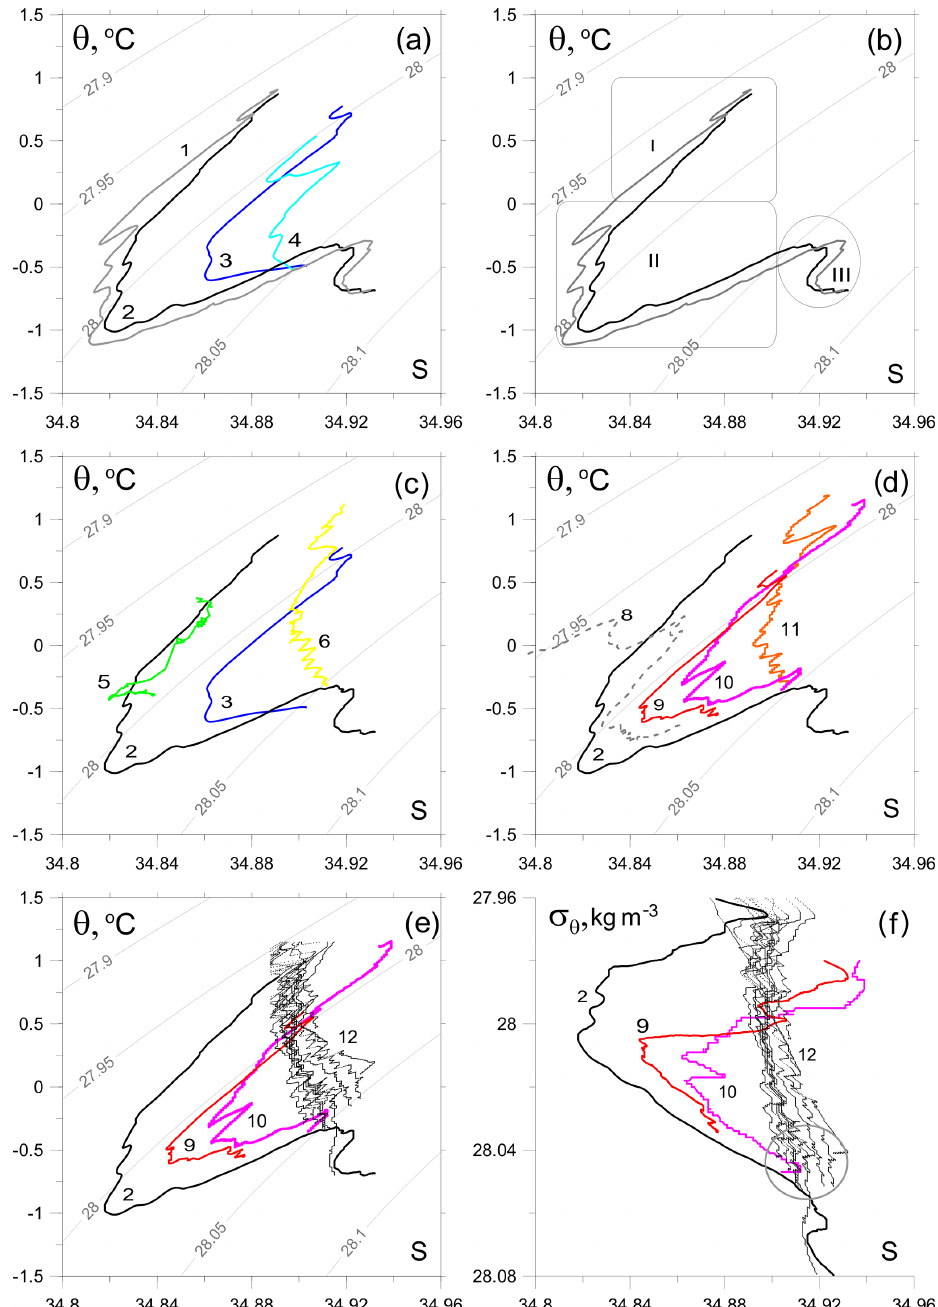
Figure 8. Thermohaline values of the BSBW and FSBW. (a) Based upon the CTD profiles, obtained in the St. Anna Trough (NABOS09, section 82 ◦ N); curves 1–4 correspond to the stations (st.) 76, 78, 83, and 80, respectively. (b) The same as (a) but only curves 1 and 2 are presented; regions I, II, III illustrate three different water masses in accordance with Dmitrenko et al. (2015); for an explanation, see the text. (c) Based upon the section of PS96, curves 5 and 6 corresponding to st. 32 and 42, respectively (depth range 600–1000m), curves 2 and 3 are shown for the reference. (d) For CTD profiles in the 103 ◦ E section, NABOS09, curve 8 (st. 64), curve 9 (st. 63), curve 10 (st. 62), curve 11 (st. 60), and curve 2 for the reference (see Fig. 5 for the location of the stations). (e) Based upon the CTD profiles in the depth range 500–1200m measured at 126 ◦ E (section of NABOS09), curves 12; curves 2, 9, and 10 are shown for the reference. (f) The same as (e) but presented in coordinates σ θ and S